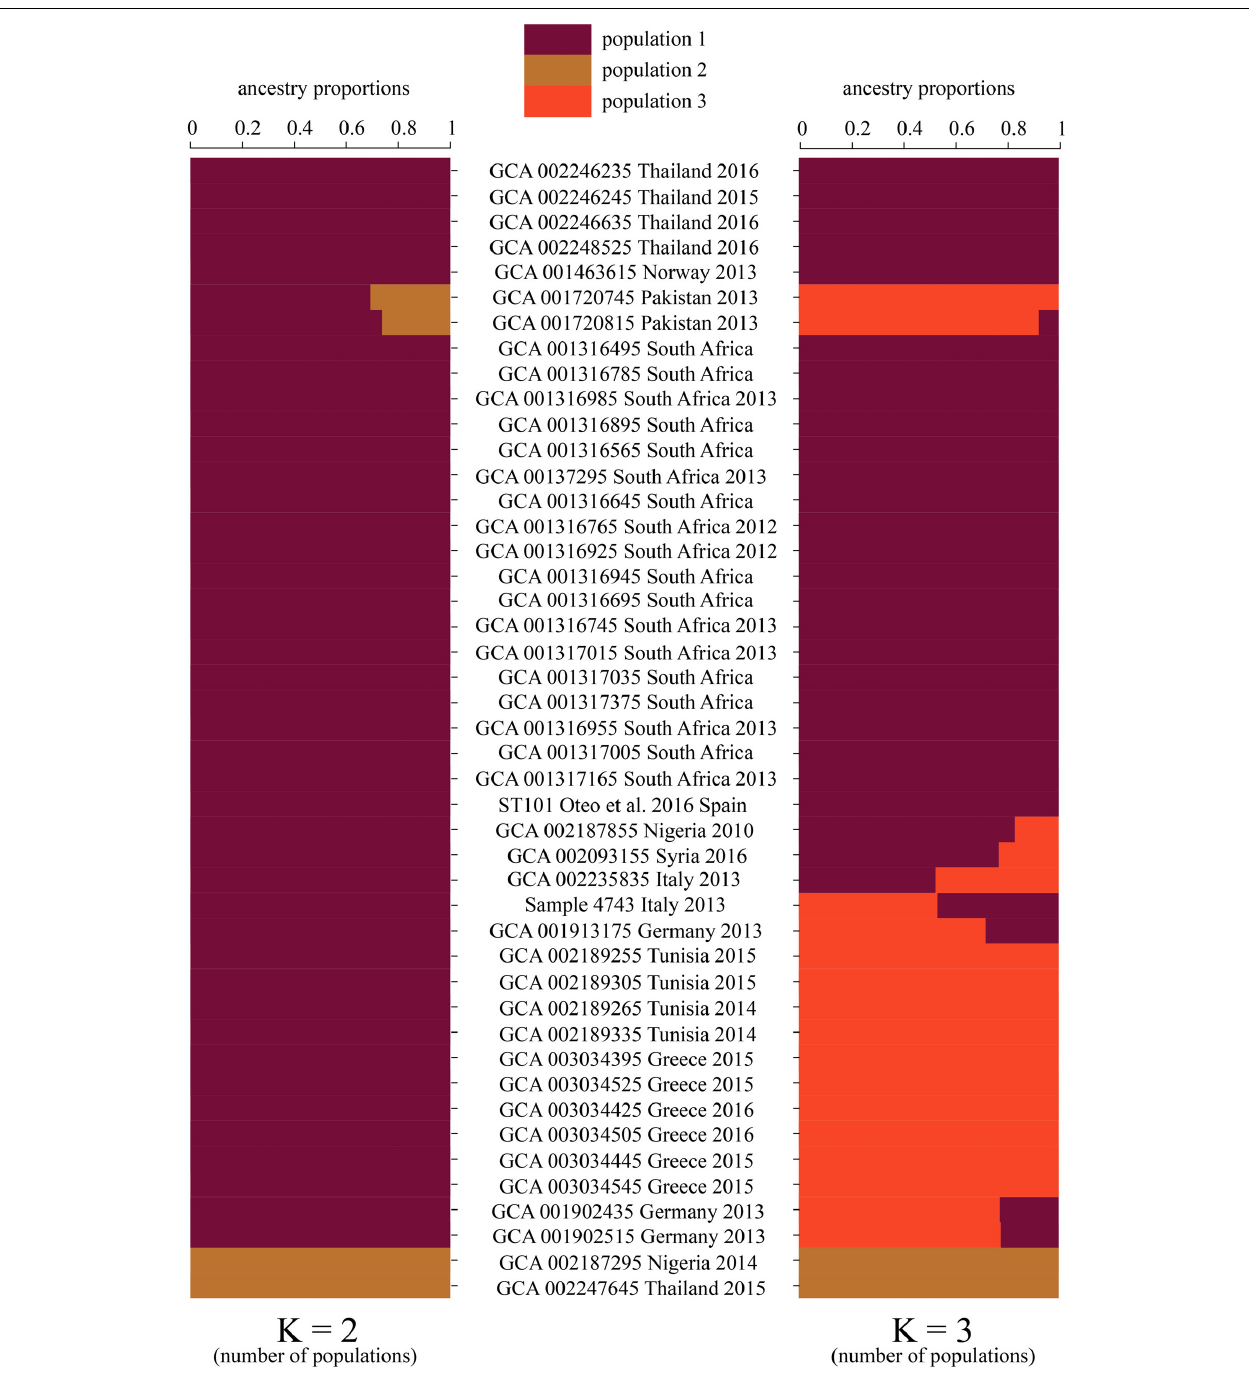
FIGURE 2 | Ancestry proportions were inferred for the ST101 lineage using fastStructure v1.0 with the optimal choices of K (populations). Two different K -values (number of populations) were selected as most appropriate, K = 2 and K = 3. K = 2 graph represents two populations with little shared ancestry between them. Population one is represented by dark red. Population two is distinguished as brown. When running fastStructure with the number of expected populations set at three ( K = 3), we observed limited shared ancestry.